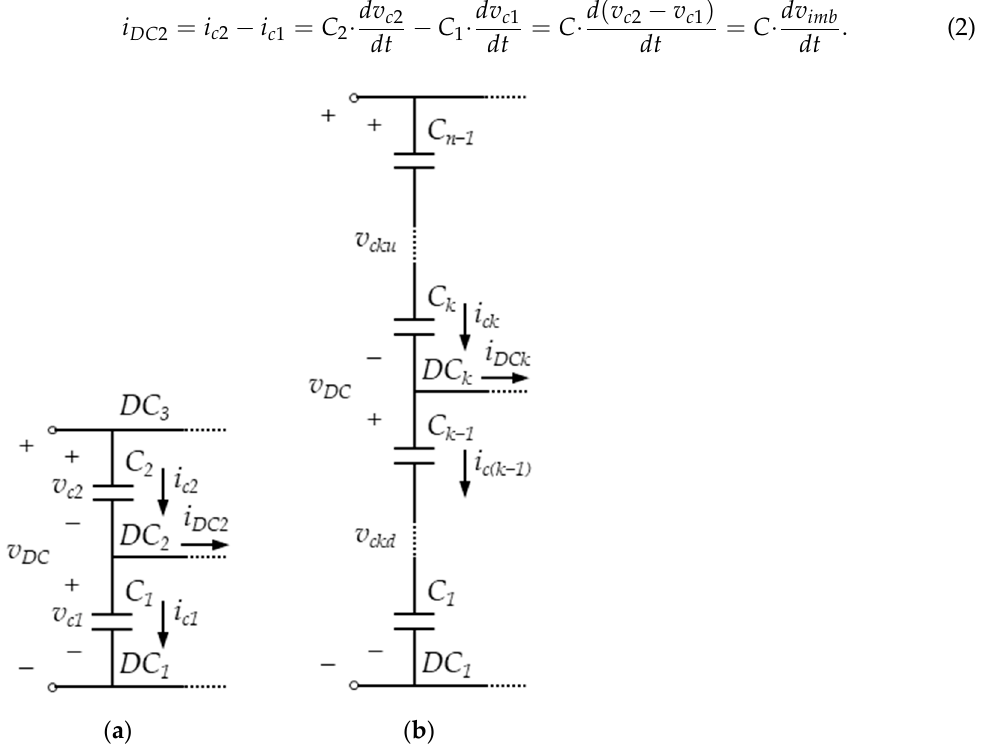
Figure 8. Relationship between the neutral-point current and the DC-link capacitor balance: ( a ) 3-level case; ( b ) n -level case.